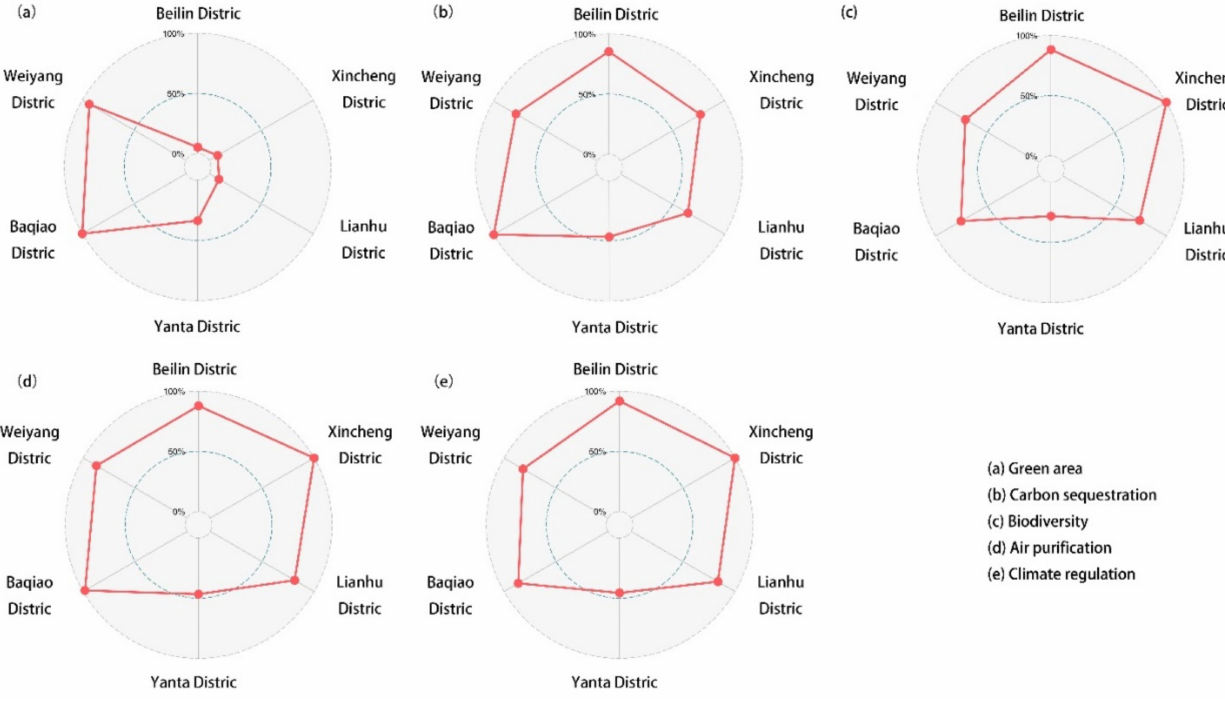
Figure 5. Per capita green space area and ecosystem services in the administrative region of the main urban area of Xi’an City. ( a ) Green area. ( b ) Carbon sequestration. ( c ) Biodiversity. ( d ) Air purification. ( e ) Climate